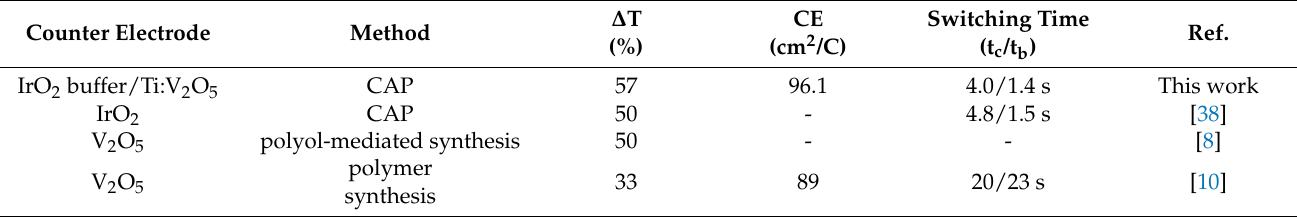
Table 4. Comparison of recent research on electrodes under various